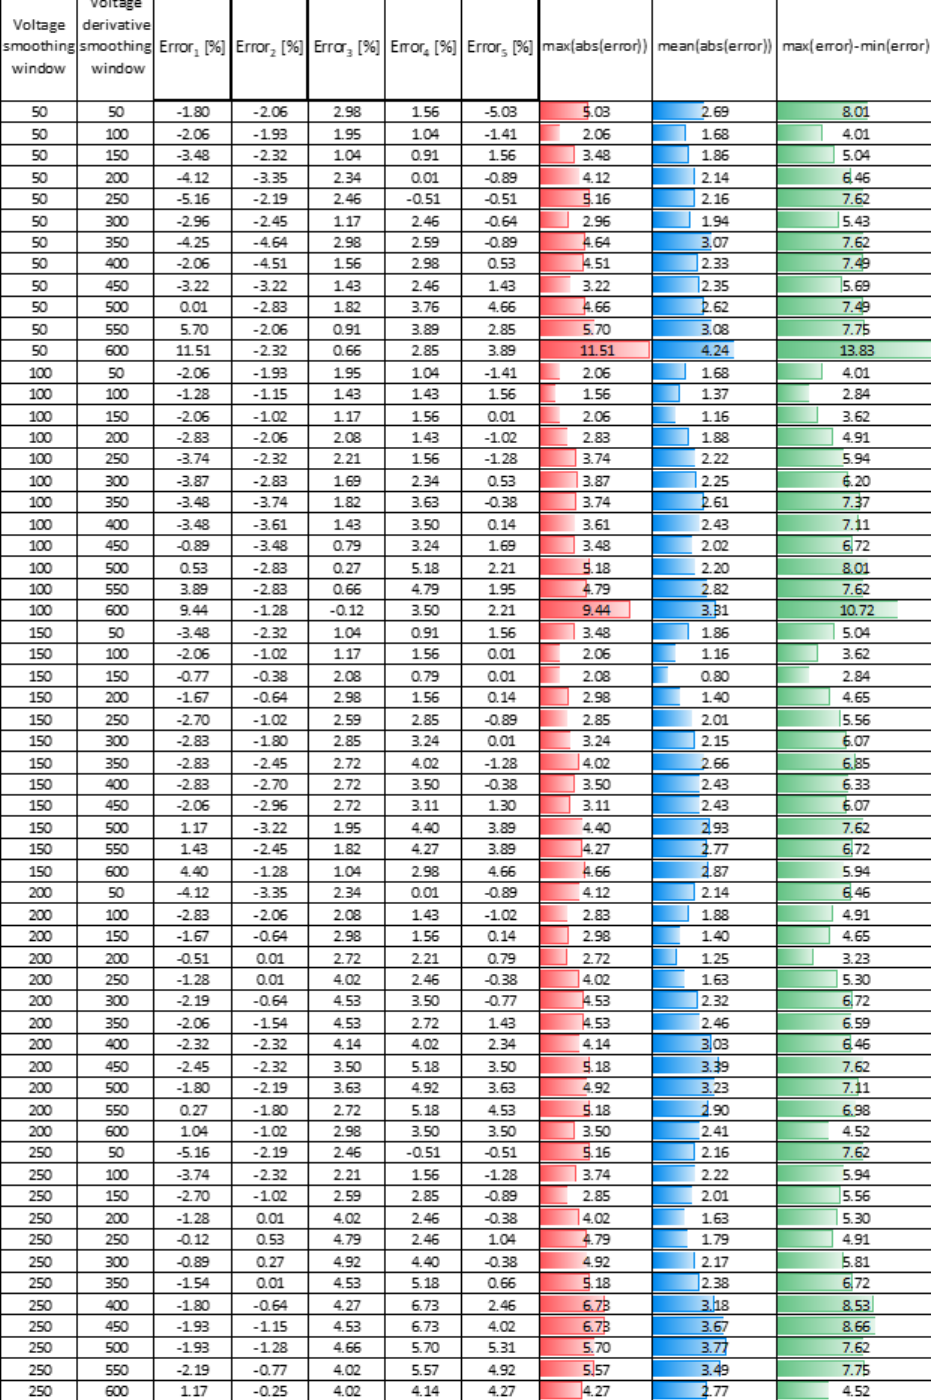
Figure A38. Load voltage second